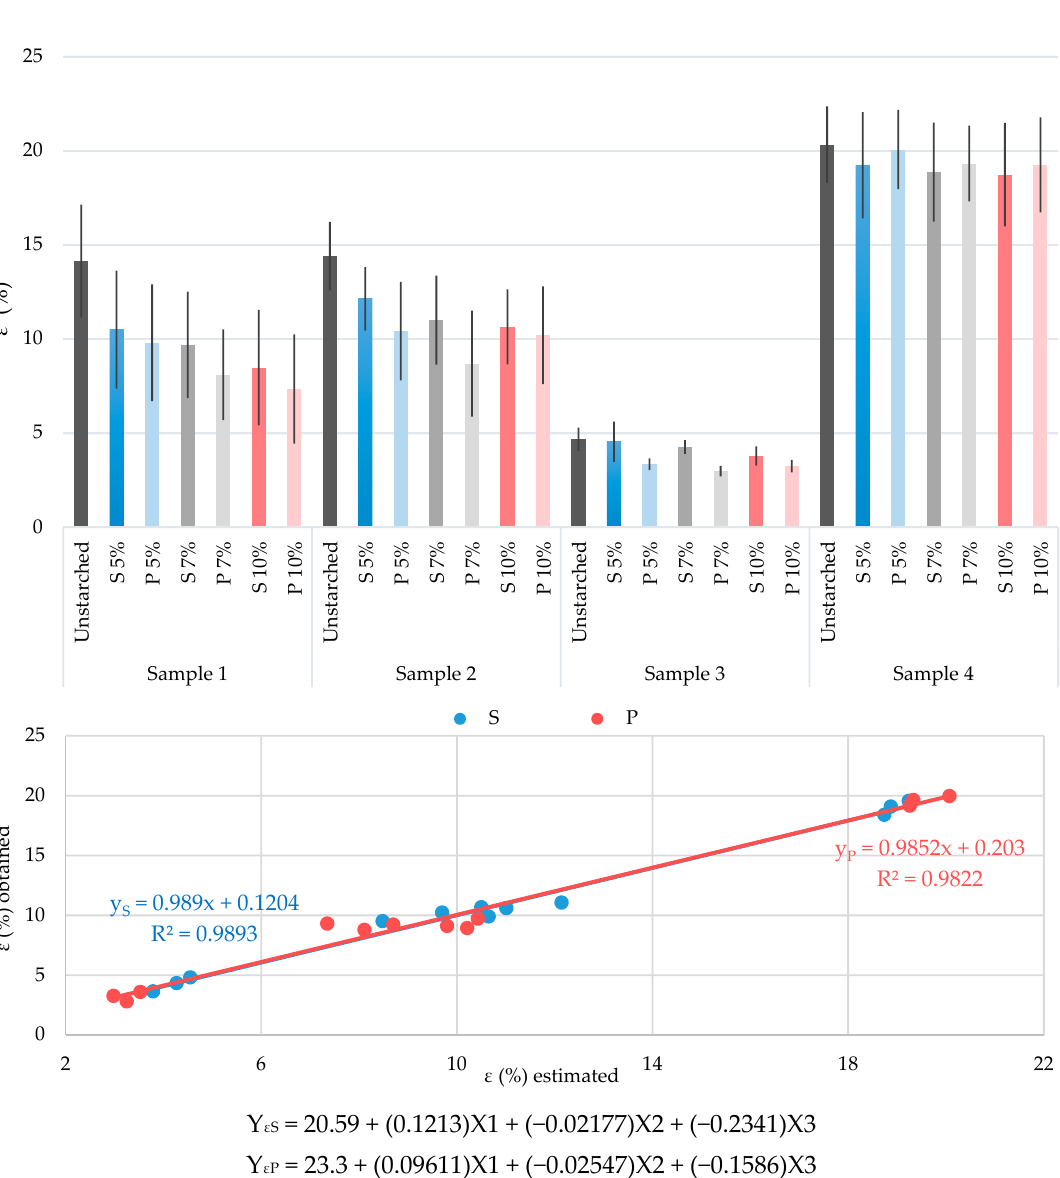
Figure 3. Diagram of elongation at break ( ε ) of the tested yarns: unstarched yarn and starched yarn by standard and prewetting processes, with 5%, 7% and 10% starch mass concentration.